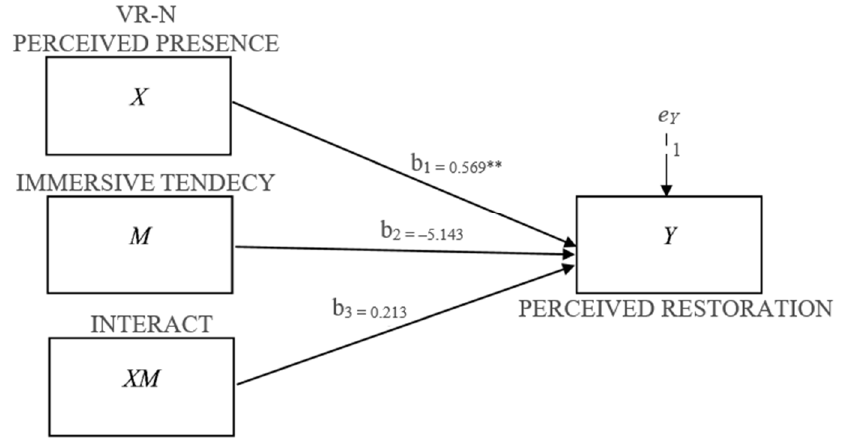
Figure 6. A statistical diagram of the simple moderation model tested in Hypothesis 6. ** p < .001. X = predictor variable, M = moderator variable, XM = interaction between predictor and moderator, Y = the outcome variable. b 1 –b 3 = beta values